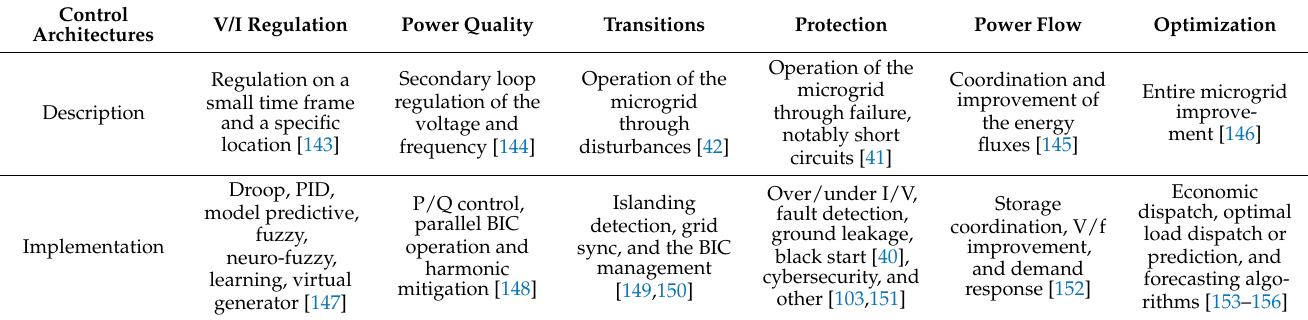
Table 6. Description and implementation of the different architectures.